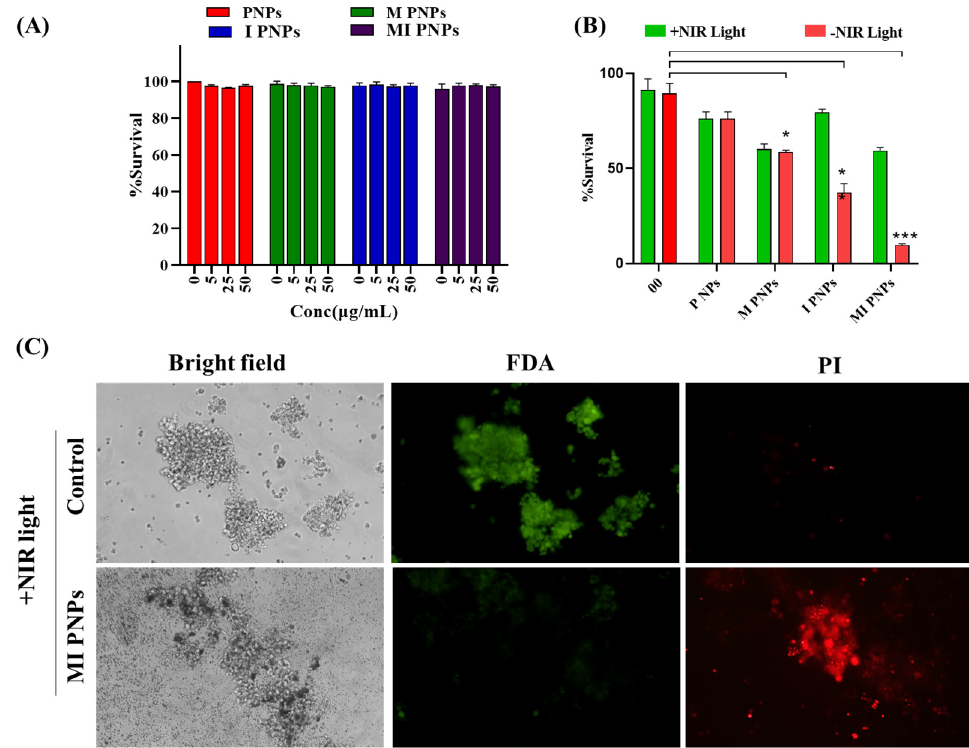
Figure 6. ( A ) Biocompatibility studies of the MI PNPs at various concentrations in HRMEC cell lines. ( B ) Photothermal-mediated cytotoxicity studies of the MI PNPs and reference controls in the presence or absence of the NIR light. ( C ) Fluorescent microscopy images of the FDA/PI-stained cells after treatment and exposure to NIR 808 nm light. (Scale bar represents 100 μ m). A two-way ANOVA was used to perform the statistical analysis in ( B ). * p < 0.05 and *** p < 0.001. Overall, the studies indicated that the MI PNPs were found to be